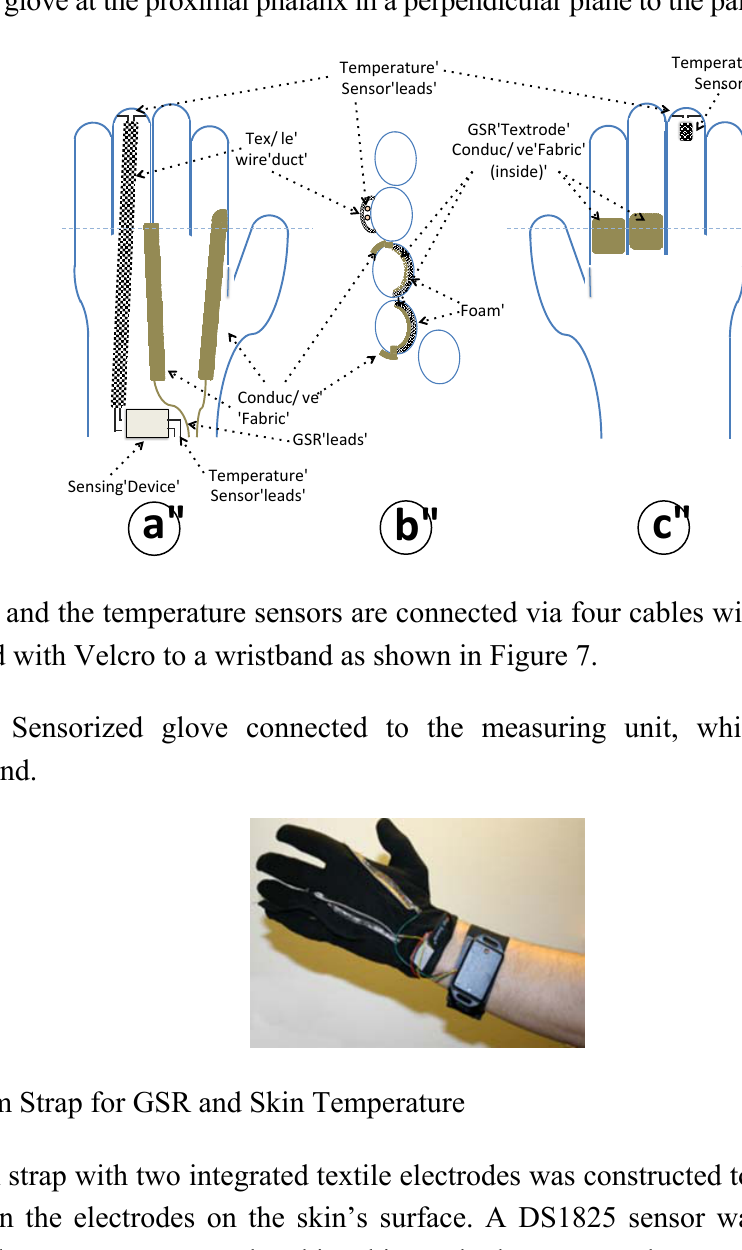
Figure 6. Schematic of the sensorized glove. ( a ) Upper view of the glove. ( b ) Cross-sectional view of the glove at the proximal phalanx in a perpendicular plane to the palm. ( c ) Palm view.